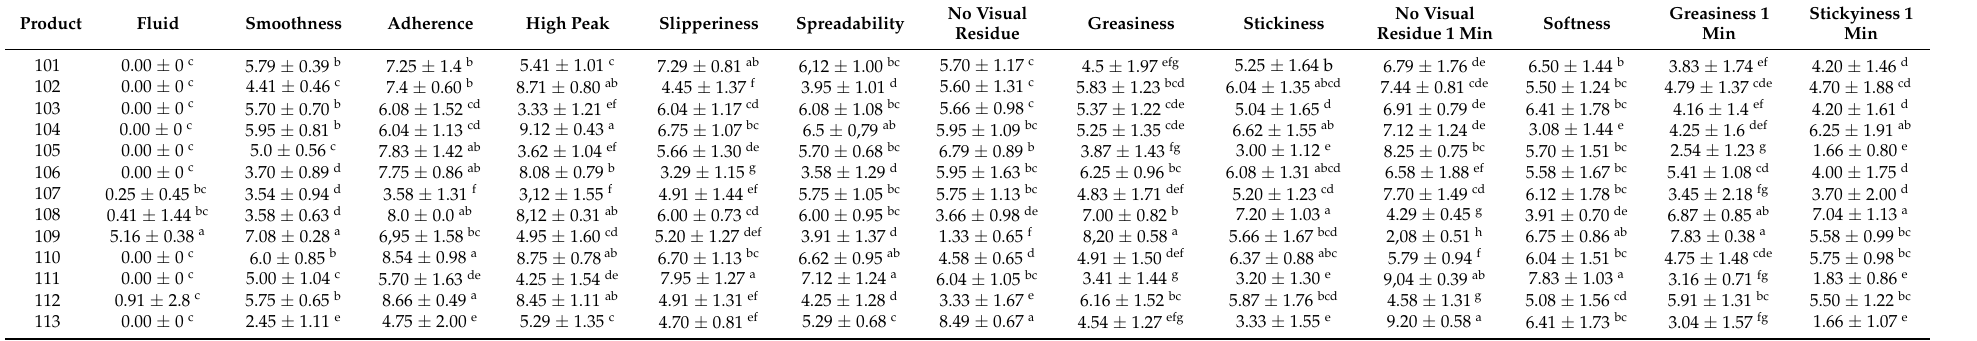
Table 3. Average score ( ± sd) of the panelists of each attribute for the 13 cosmetic